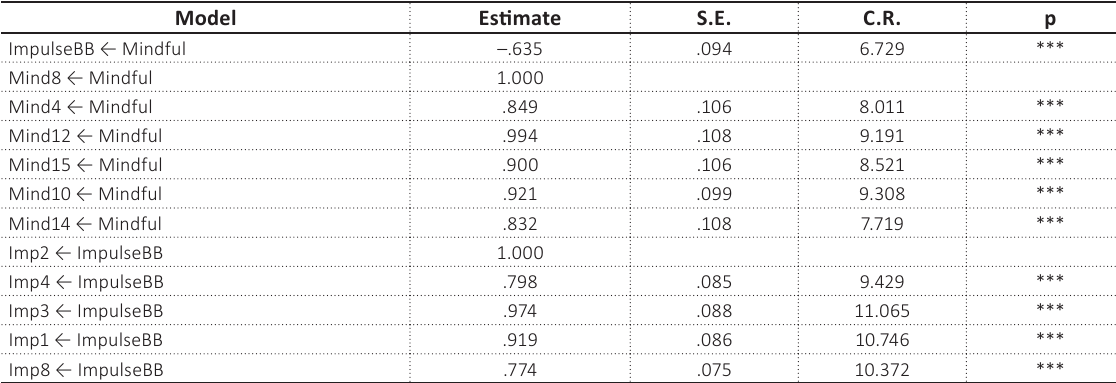
Table 7. The regression analysis results of the research model Model Estimate S.E. –.635